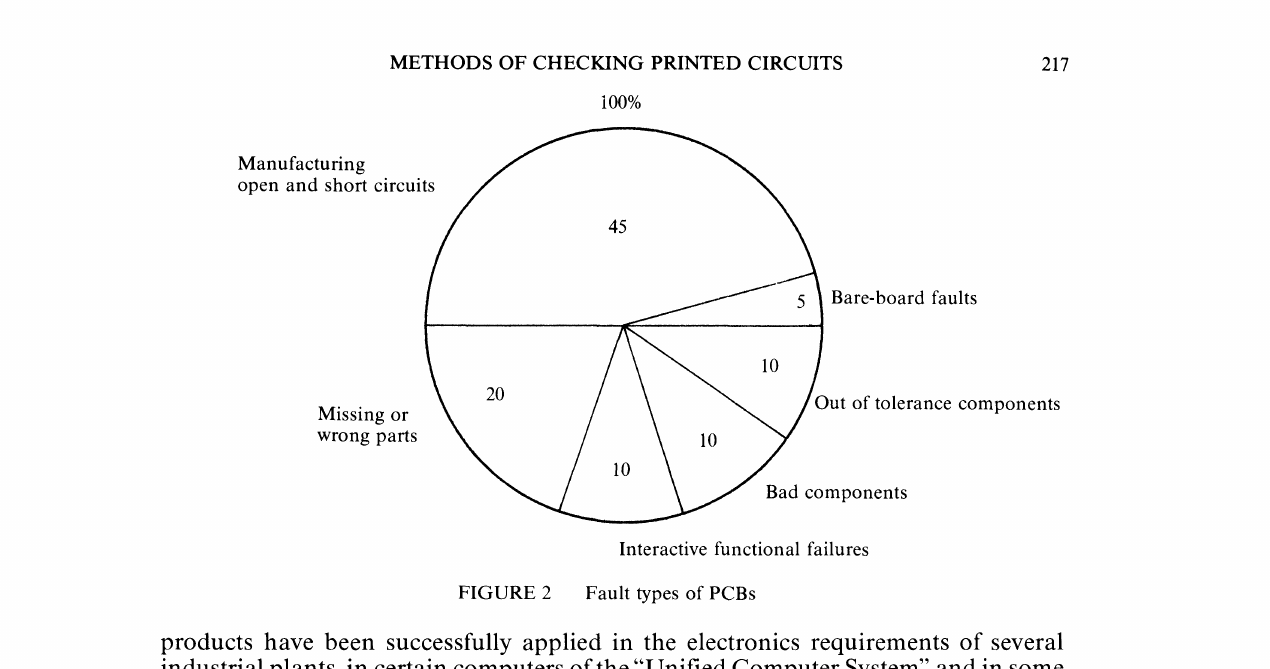
FIGURE 2 Fault types of